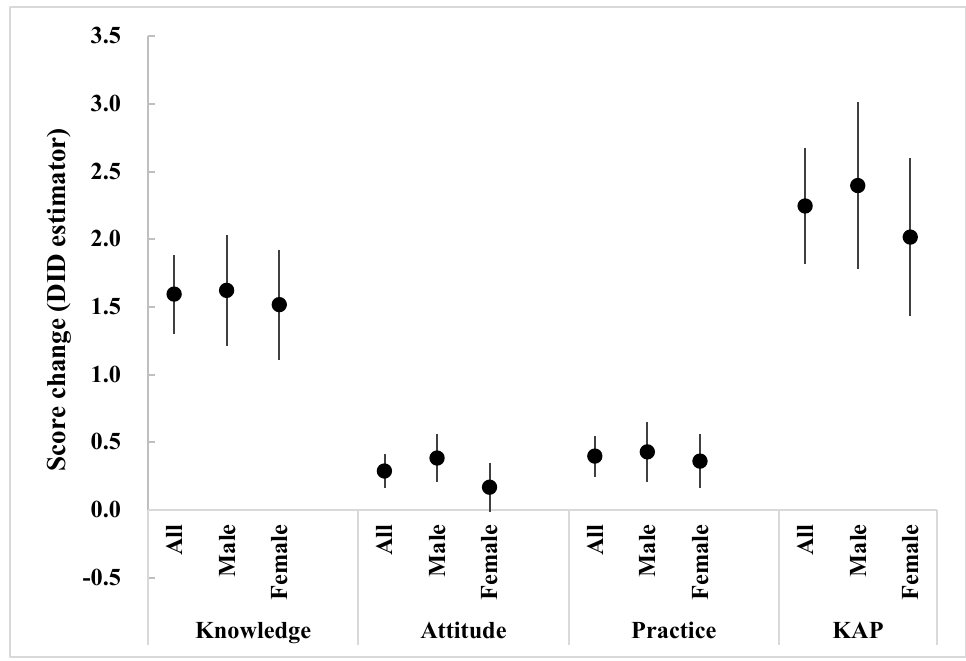
Figure 1. Sex-specific KAP score changes after intervention for students in the intervention school compared with the control school (adjusted with age by difference − in − difference (DID) analysis; KAP represents the total score of knowledge, attitude, and practice; score changes mean DID estimators).